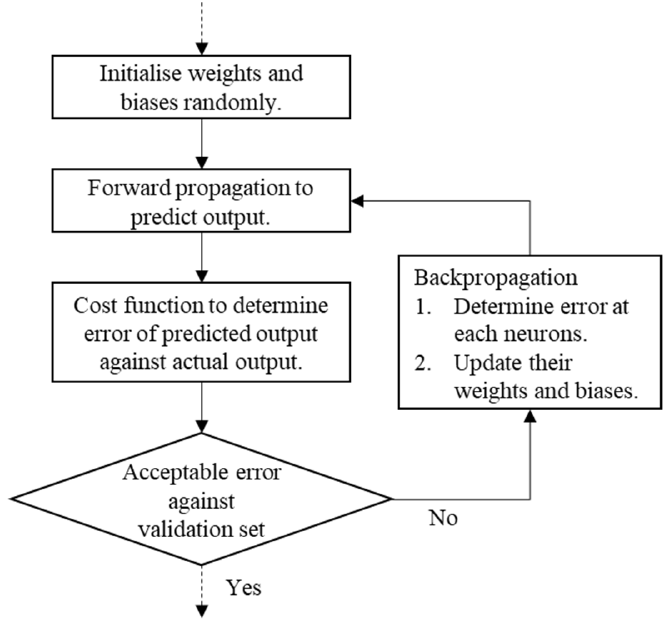
Figure 8. Training process of neural network.